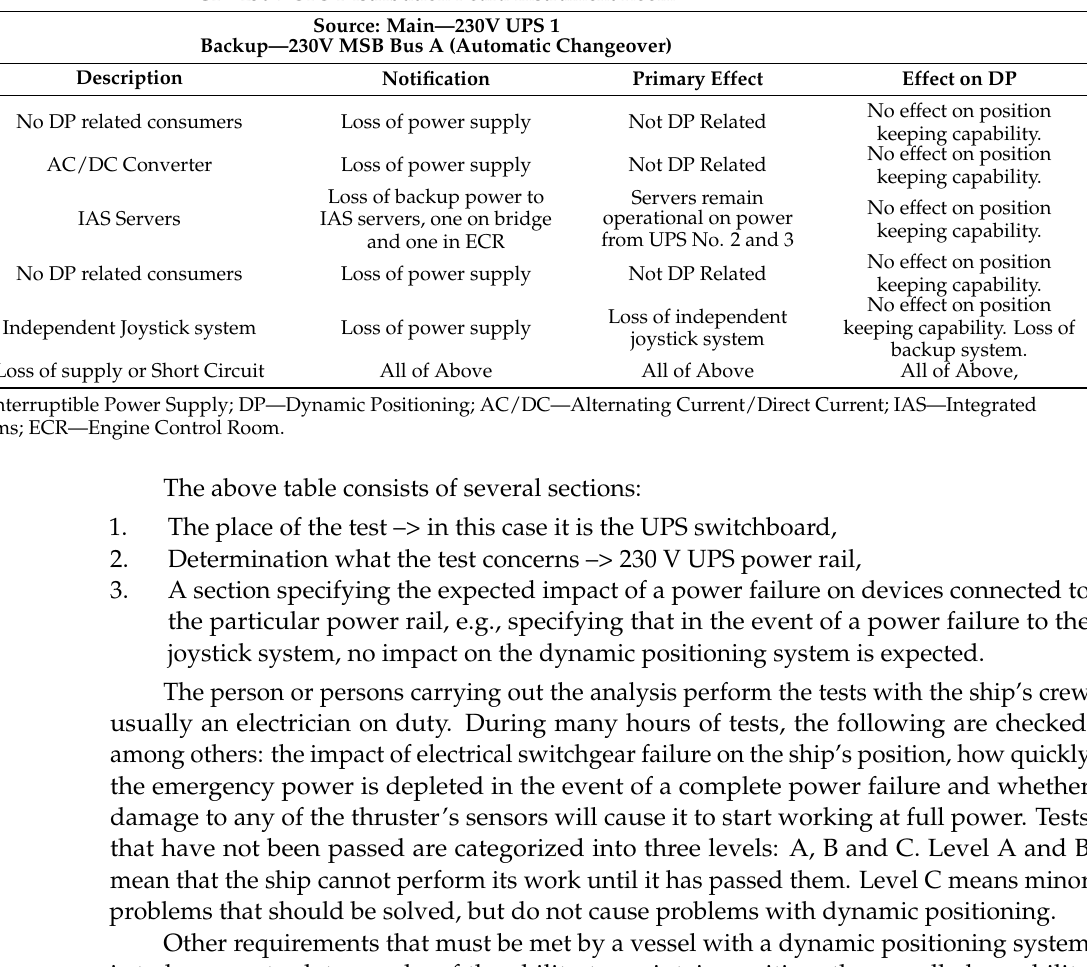
Table 1. Sample fragment of FMEA tests concerning UPS power failure [23]. C1—230V UPS Distribution Board Instrument